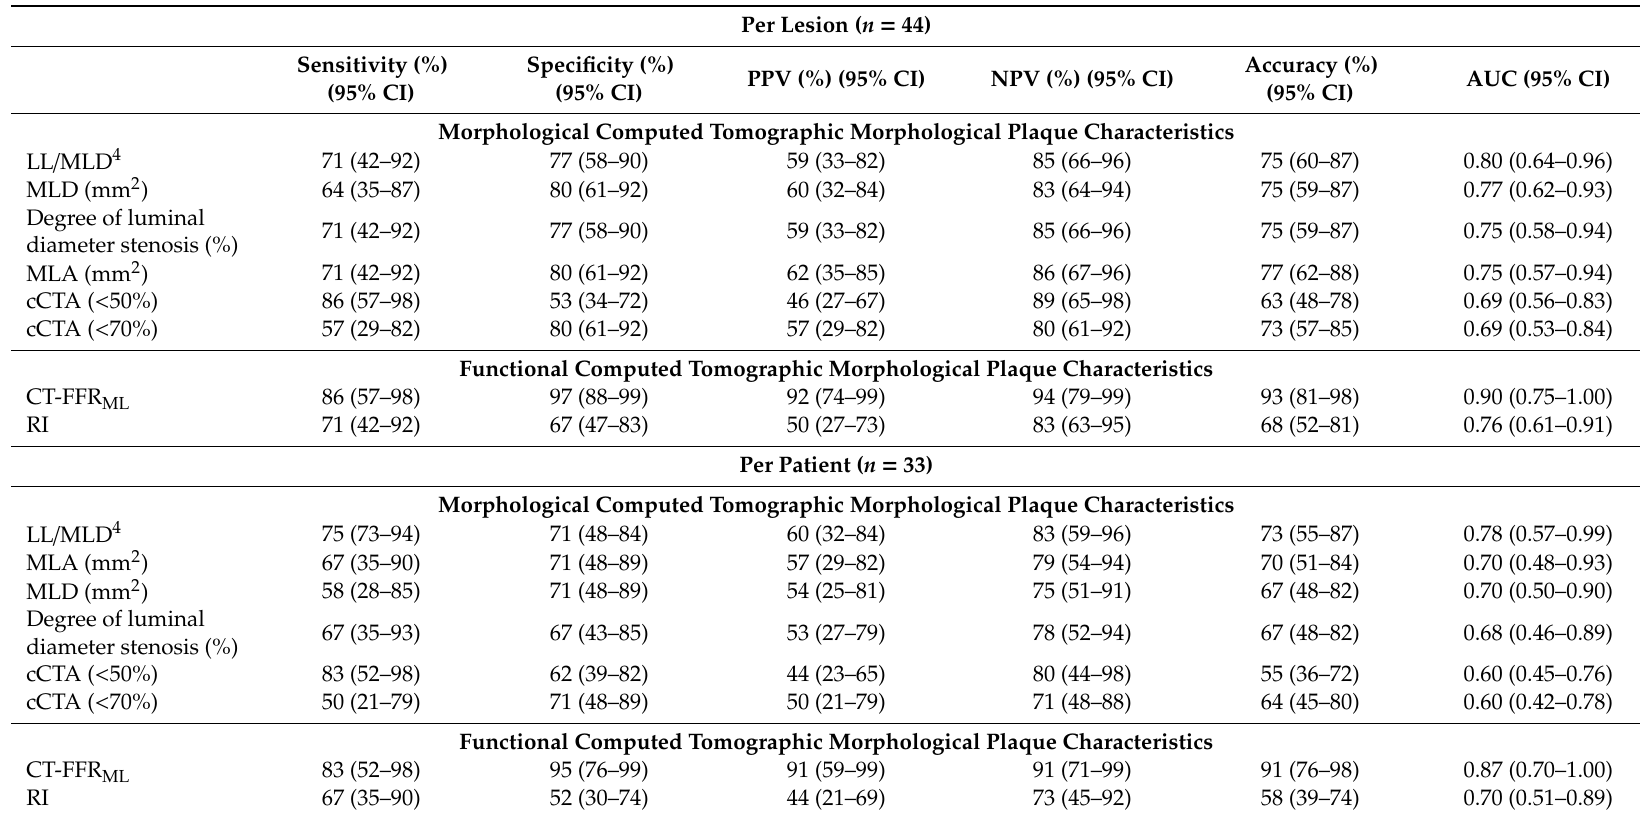
Table 3. Diagnostic performance of fractional flow reserve derived from coronary-computed tomography angiography based on machine learning algorithm and coronary-computed tomographic plaque characteristic on a per-lesion and per-patient level using RFR TM as the reference